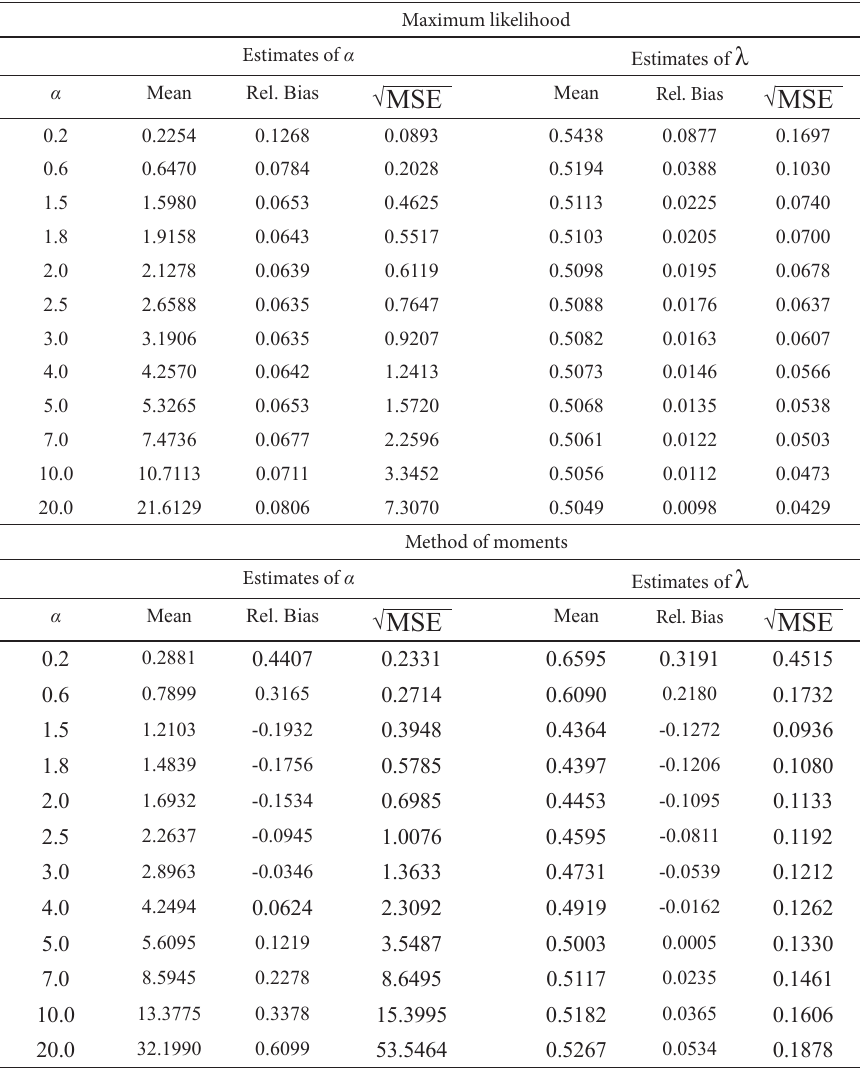
Point estimates for n =50 and different values of